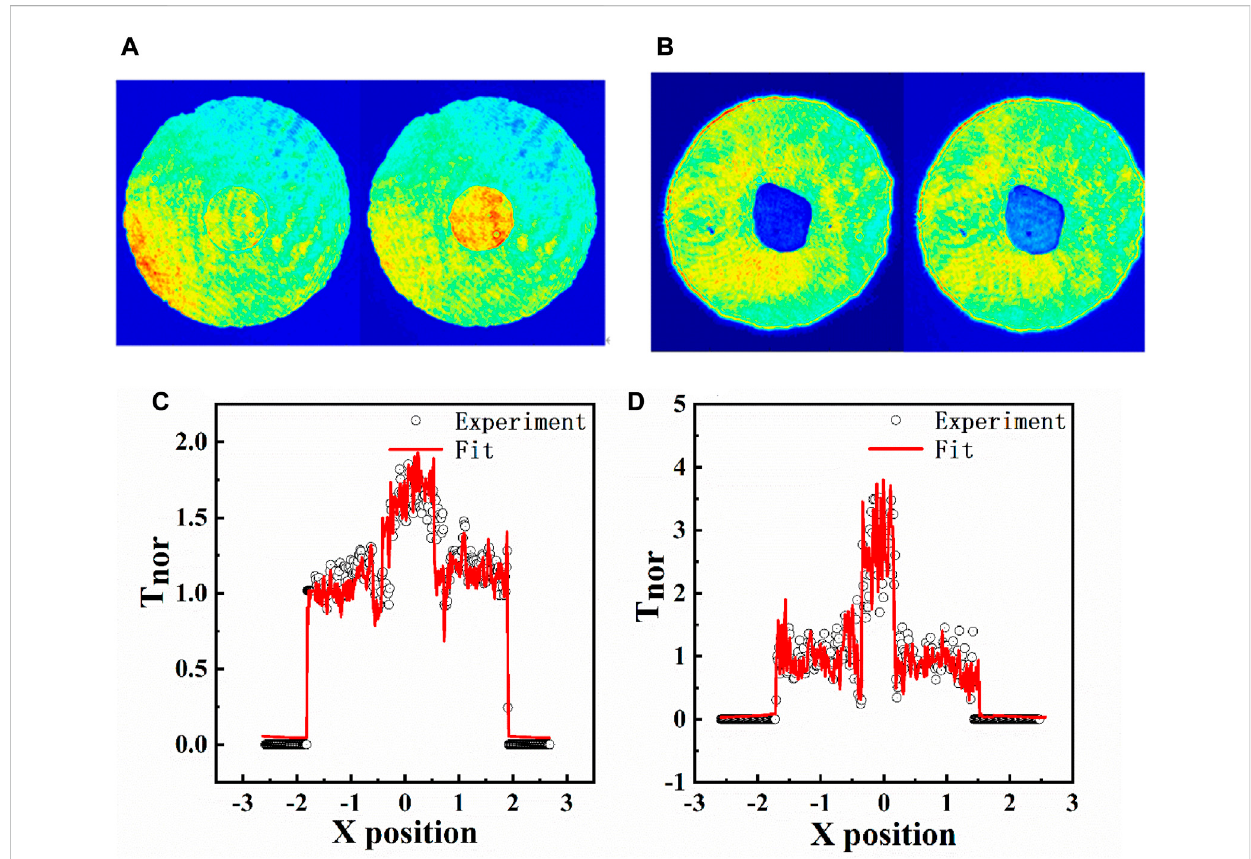
FIGURE 6 (A,B) Linear and non-linear images for CS 2 as acquired by our experimental 4f imaging system with a conventional transparent PO and absorptive (T PO ≈ 16%) HPOs. (C,D) Pro fi les of images (A,B) by processing T NL / T L ; the red solid lines are theoretical